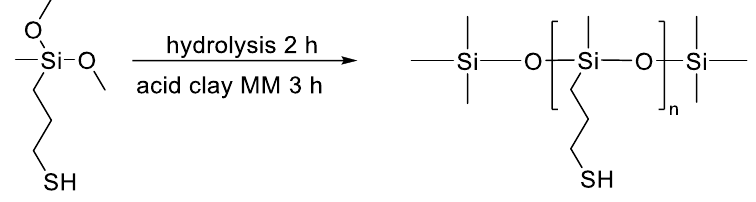
Figure 30. Scheme for obtaining PMMS.